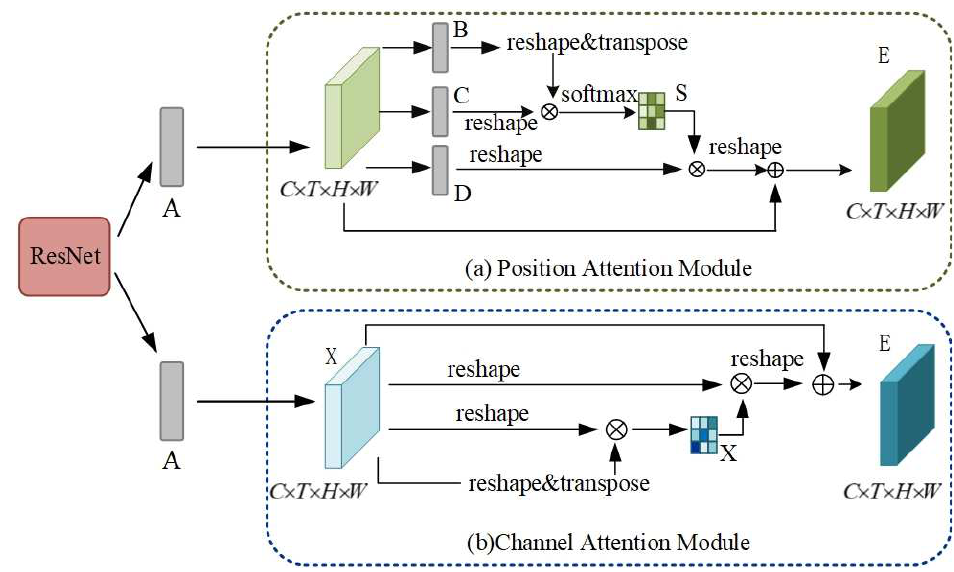
Figure 2. The details of the position attention module and channel attention